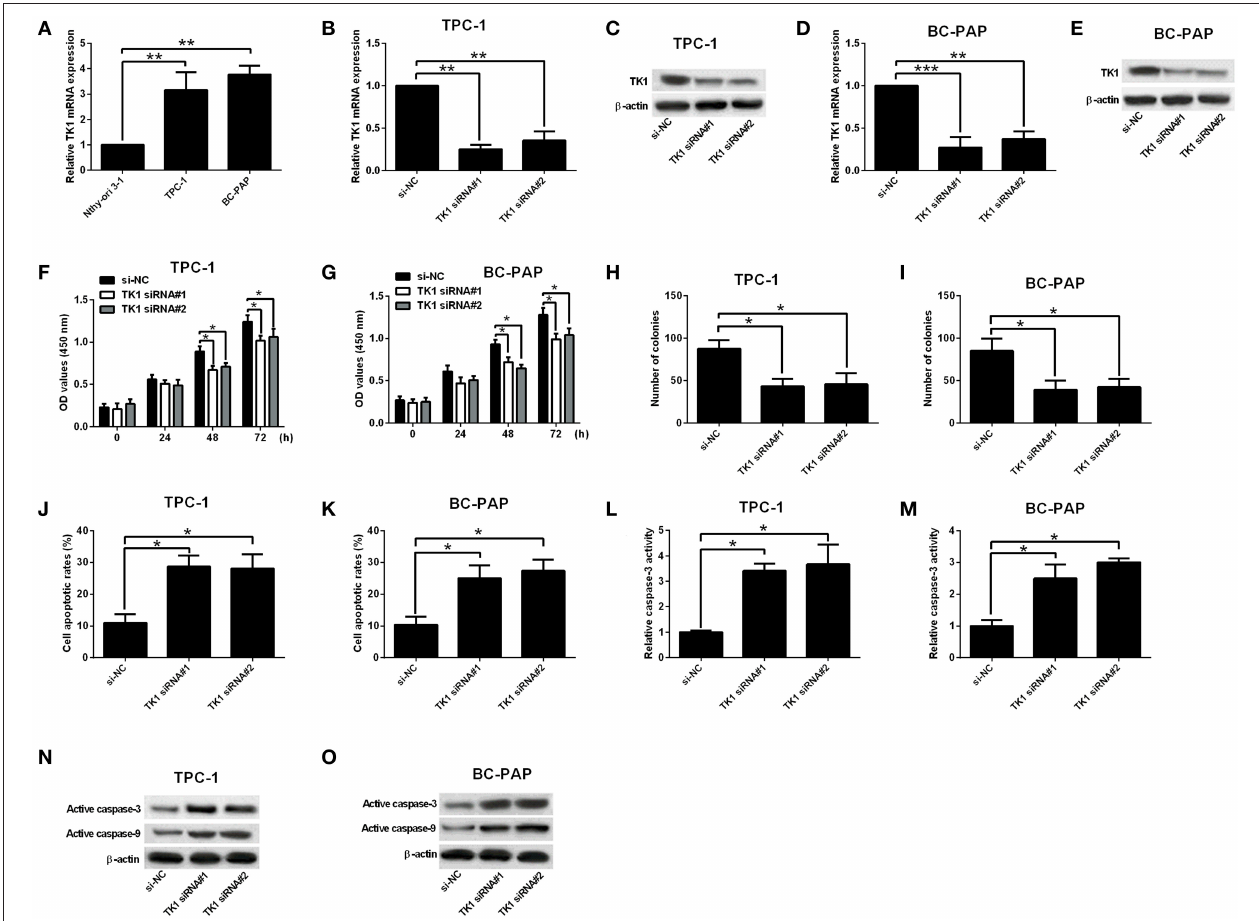
FIGURE 2 | Thymidine kinase 1 (TK1) knockdown suppressed thyroid carcinoma cell proliferation and induced cell apoptosis. (A) Quantitative real-time PCR (qRT-PCR) analysis of TK1 messenger RNA (mRNA) expression level in normal thyroid follicular epithelial cells and thyroid carcinoma cells (TPC-1 and BC-PAP). (B–E) qRT-PCR and Western blot analysis of TK1 mRNA and protein expression levels in TPC-1 and BC-PAP cells after scrambled siRNA (si-NC) or TK1 siRNAs (TK1 siRNA#1 or #2) transfections. (F,G) Cells proliferation by CCK-8 assay was determined in TPC-1 and BC-PAP cells, respectively. (H,I) Colony formation ability was assessed in TPC-1 and BC-PAP cells, respectively. (J,K) Flow cytometry analysis was used to detect the cell apoptotic rates in TPC-1 and BC-PAP cells, respectively. (L,M) Caspase-3 activity assay was used to determine the capsase-3 activity of TPC-1 and BC-PAP cells, respectively. (N,O) Protein expression levels of active caspase-3 and caspase-9 in TPC-1 and BC-PAP cells were detected by Western blot, respectively. N = 3; * P < 0.05, ** P < 0.01, and *** P <